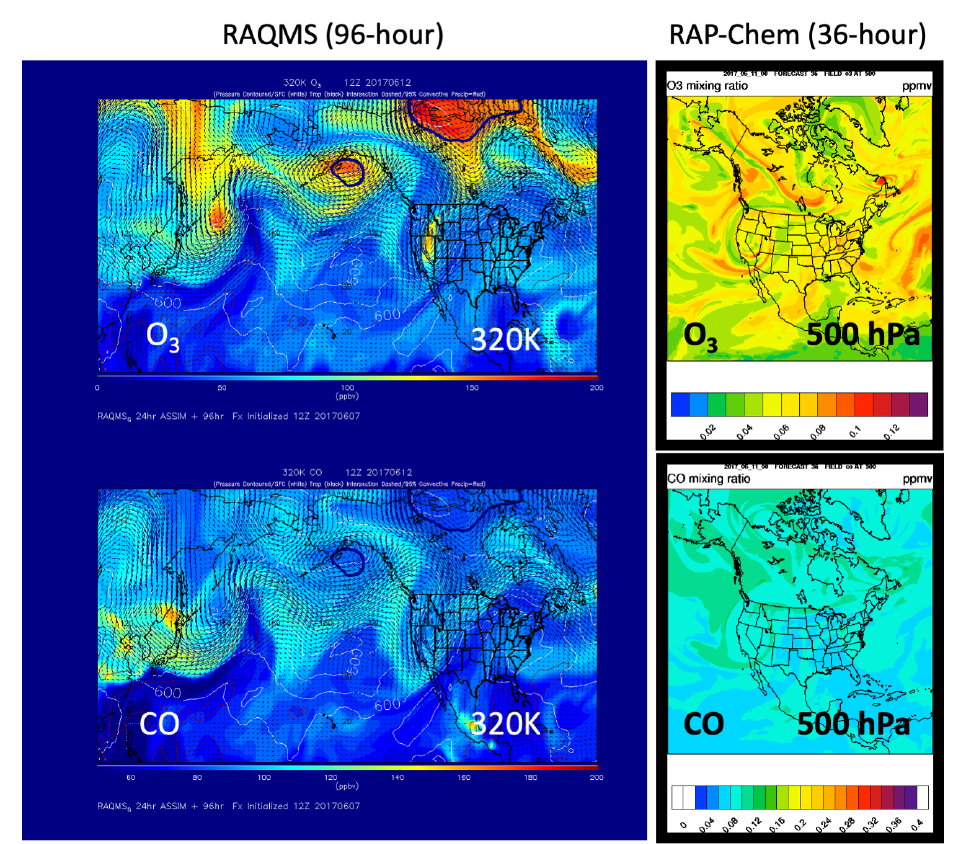
Figure 8. RAQMS (left) and RAP-Chem (right) O 3 (top) and CO (bottom) forecasts for 12:00UT 12 June 2017. The 320K RAQMS forecasts were initialized at 12:00UT 7 June, the 500hPa RAP-Chem forecasts at 00:00UT 11